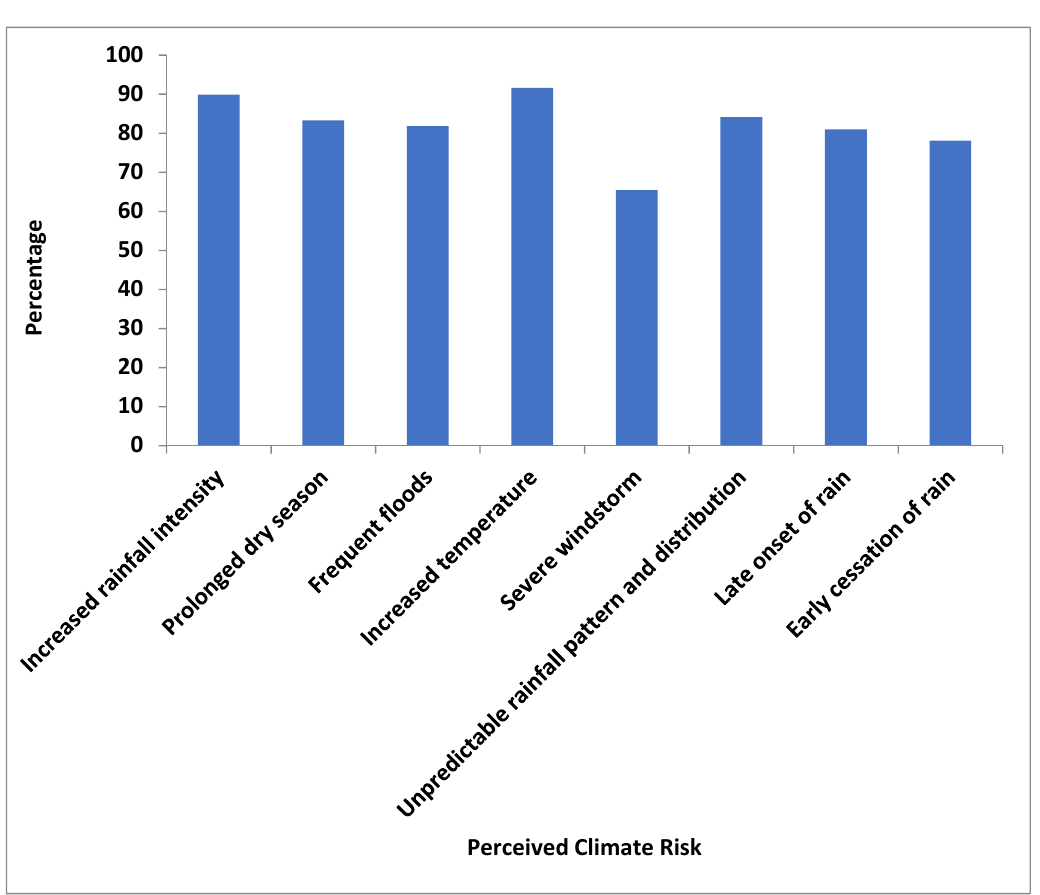
Figure 2. Farmers’ perception of climate events.